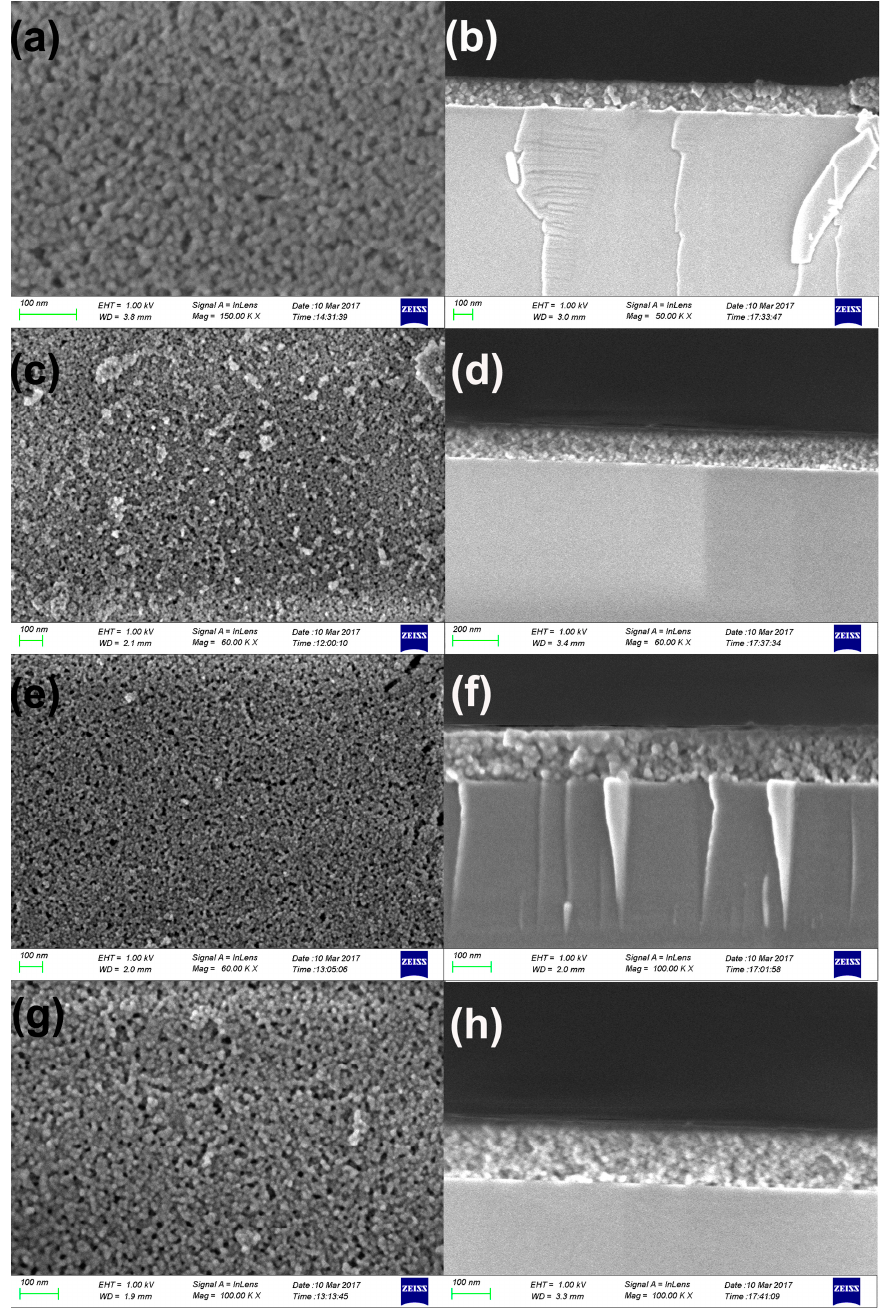
Figure 4. Top-view and cross-sectional SEM images of ARC modified F-PMHS at content of 0.0% ( a , b ), 0.25% ( c , d ), 0.5% ( e , f ), and 1.0% ( g , h ).